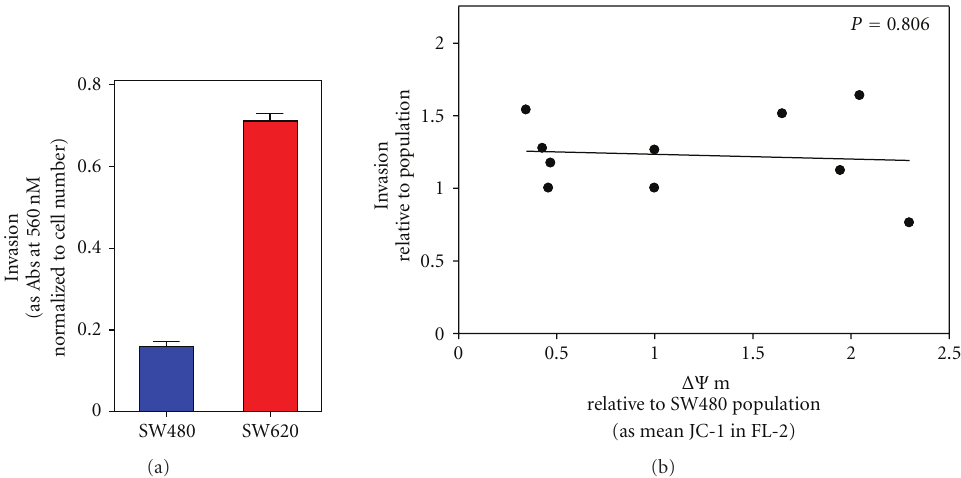
Figure 6: Di ff erences in the intrinsic ΔΨ m of subcloned cell lines derived from primary colon tumor are not linked to di ff erences in invasion. SW480 and SW620 cells (a) and subcloned cell lines derived from SW480 cells (b) were seeded into chambers containing a reconstituted basement membrane overlying a polycarbonate membrane. Invasion was quantified by staining cells adhering to the polycarbonate and determining optical density (560nM) normalized to cells/chamber. Invasion of parental SW480 and derived subclones are plotted as a function of relative ΔΨ m